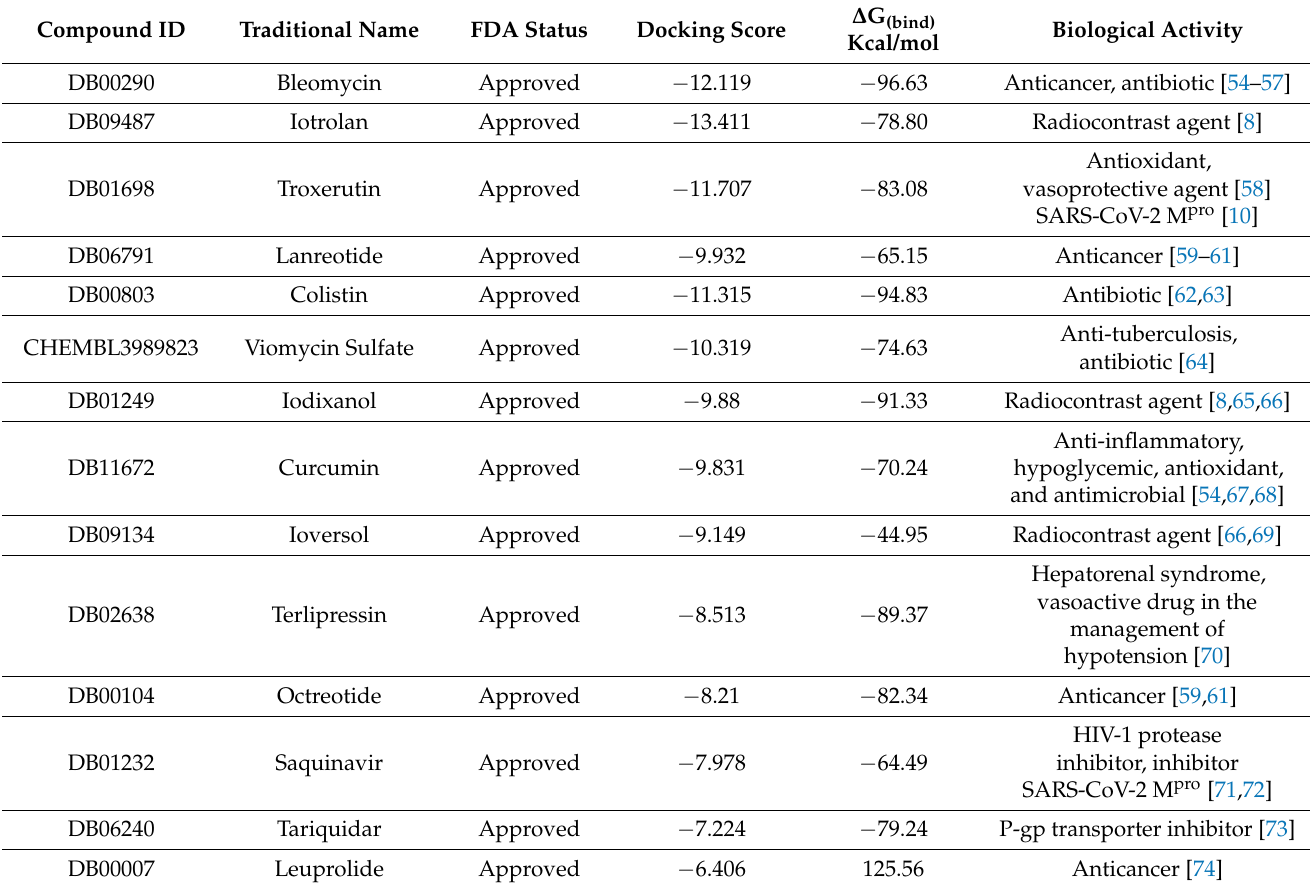
Table 1. Docking scores and binding-free energy calculations of the 15 best-ranked FDA-approved drugs against SARS-CoV-2 main protease (M pro